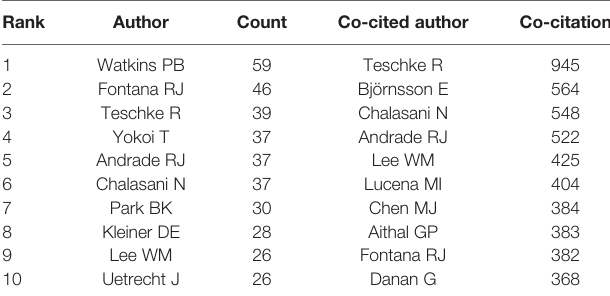
TABLE 3 | The top 10 authors and co-cited authors of DILI